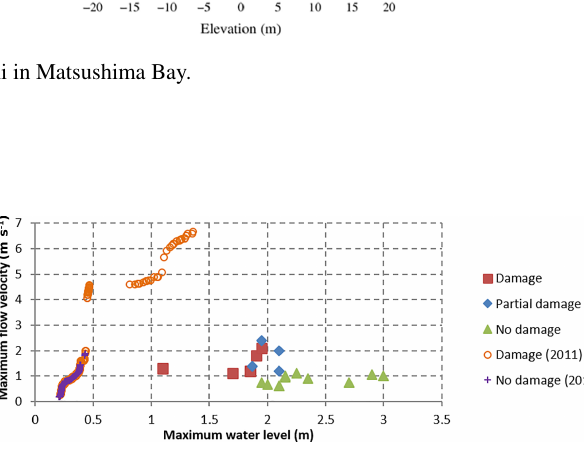
Figure 11. Comparison of the aquaculture raft data from the 1960 Chilean tsunami (Fig. 1) and the present study on the 2011 Japan